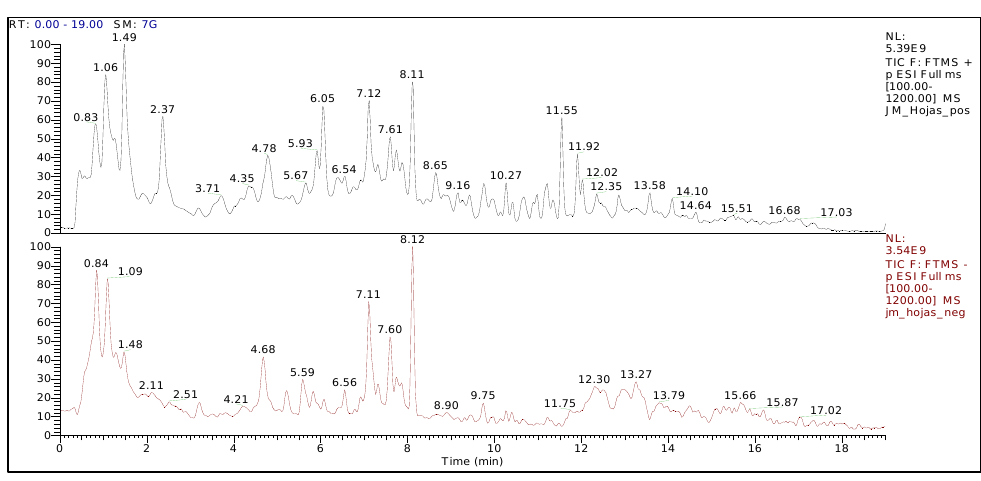
Figure 1. Chromatographic profile (LC-ESI-MS/MS) of leaves of J. macrantha ethyl acetate fraction, in both ESI (+) and ESI ( − ) ionization modes.